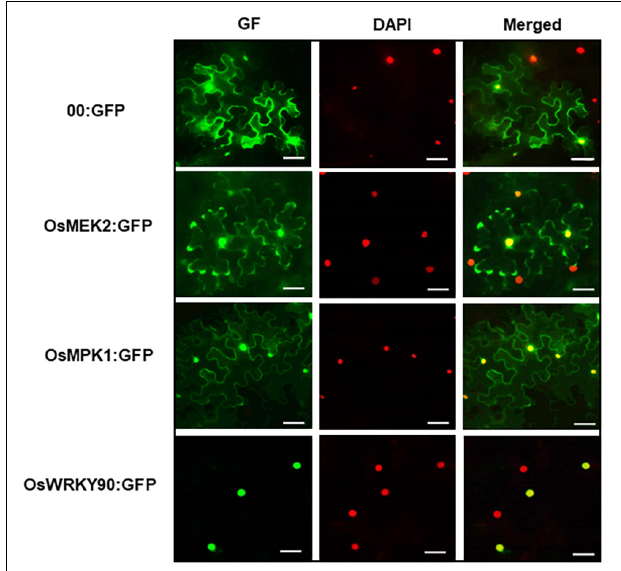
FIGURE 11 | Subcellular localization of OsMEK2, OsMPK1, and OsWRKY90 at 36 h after agroinfiltration into Nicotiana benthamiana leaves. 4 (cid:48) ,6-diamidino-2-phenylindole (DAPI) staining was used to visualize nuclei in N. benthamiana epidermal cells. Images of subcellular localization of 00:GFP, OsMEK2:GFP, OsMPK1:GFP, and OsWRKY90:GFP were taken with a fluorescence microscope using bright field, GF (green fluorescence) and DAPI filters. GFP, green fluorescent protein. Scale bars = 50 µ